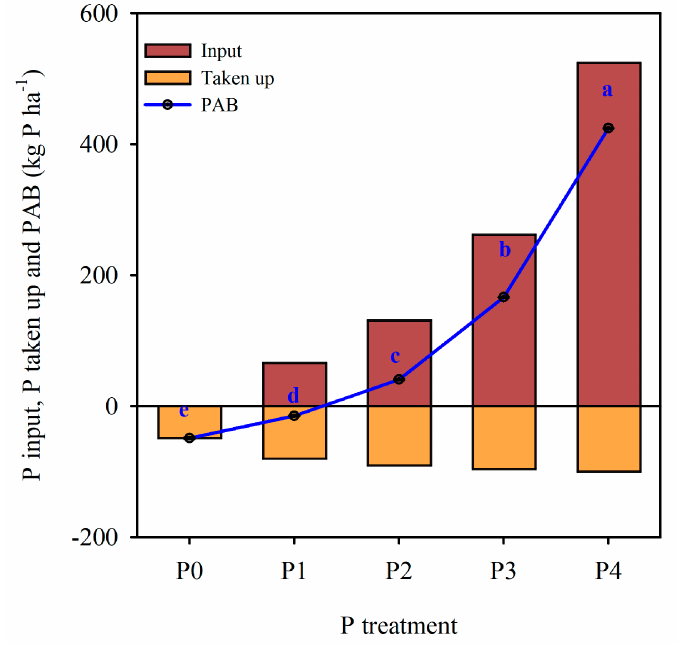
Figure 1. The soil P input, P taken up and phosphorus apparent balances (PAB) from 2017 to 2019 (kg P·ha − 1 ). Note: Mean ± Standard deviations, different letters above column indicate significant difference ( p < 0.05) between various treatment. The different letters indicate statistically significant differences between the treatments at the Po0.05.